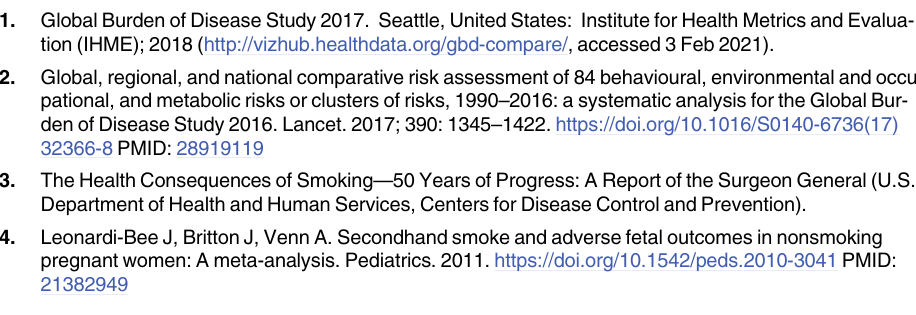
S8 Table. Results from the fixed effects panel regression model for the association between total taxes and neonatal and infant mortality excluding education variables (Ratios and 95% Confidence Interval). Note: We reported ratios (i.e. exponential values of effect esti- mates) from regression models with log-transformed neonatal and infant mortality outcomes. Hausman Test indicated for each model that fixed effect model is the preferred model. Abbre- viations: VAT = value-added tax; GDP = Gross domestic product; PPP = Purchasing power parity, AIC = Akaike information criterion; BIC = Bayesian information criterion Akaike information criterion; BIC = Bayesian information